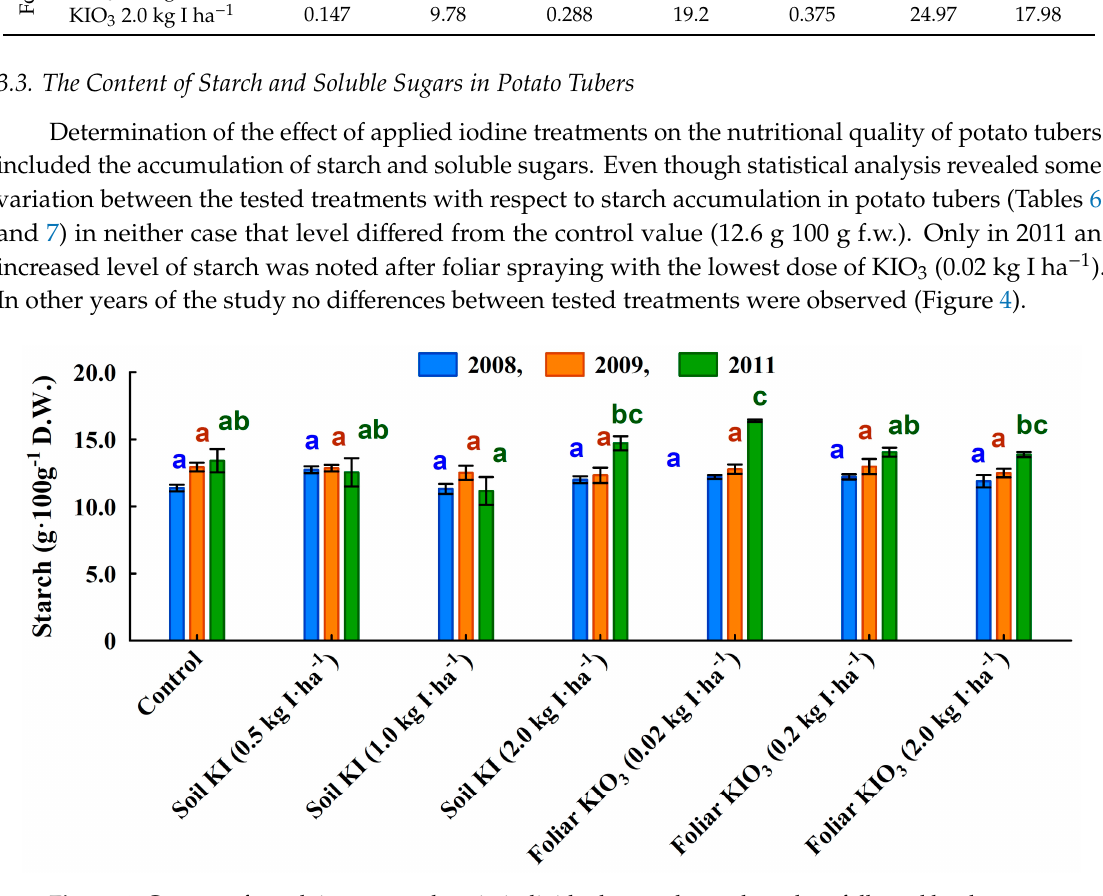
Figure 4. Content of starch in potato tubers in individual years the study; values followed by the same letters within an individual year are not statistically different at p < 0.05, ( n = 4).